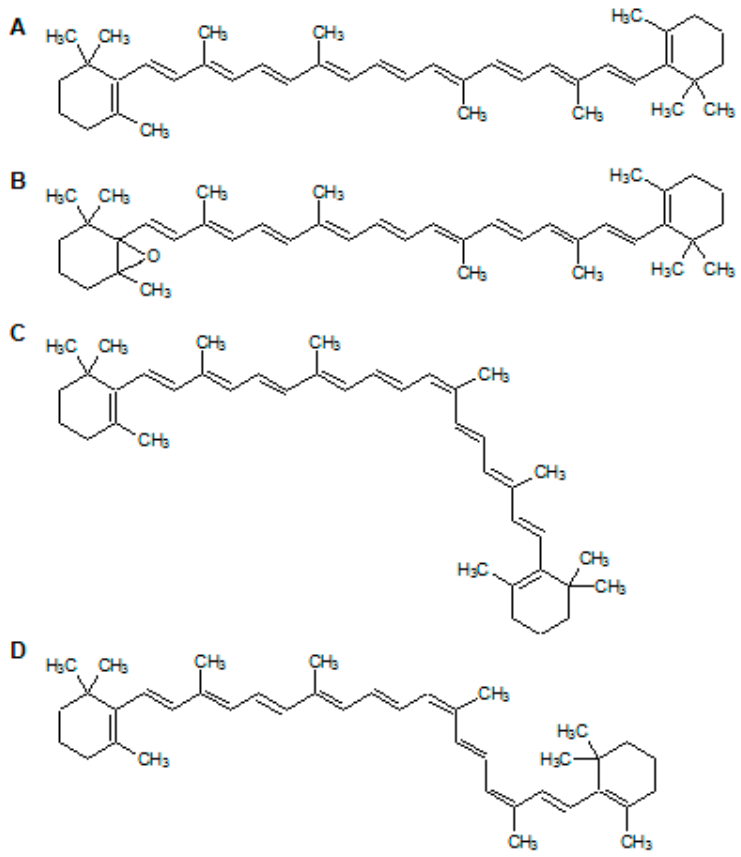
Figure 3. The structure of β -carotene and its oxidation products induced by BMFDS under UVA irradiation. ( A ) all- trans - β -carotene; ( B ) all- trans -5,6-epoxy- β -carotene; ( C ) 13- cis - β -carotene; ( D ) 9,13-di- cis - β -carotene.